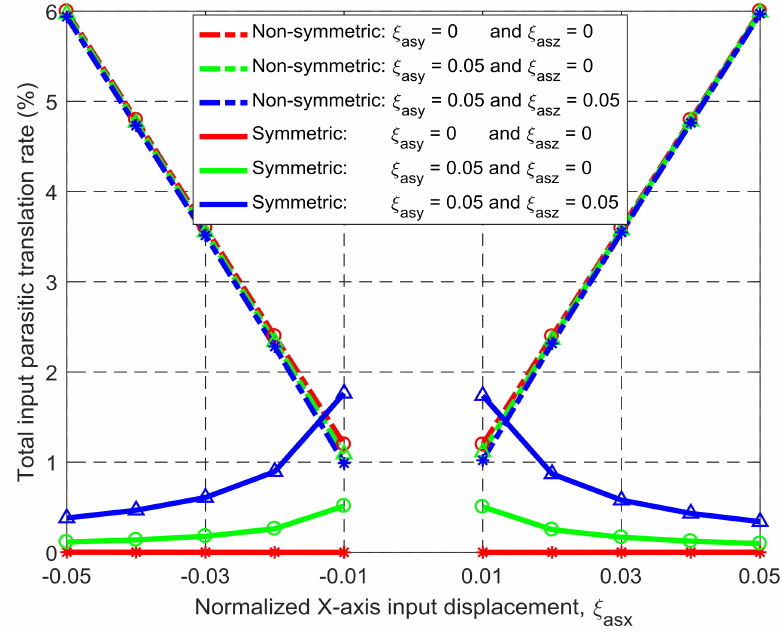
Figure 9. Comparison of input parasitic translations between the symmetric and non-symmetric XYZ CPMs shown in Figure 3a,h (Symbols, ‘*’, ‘ (cid:52) ’ and ‘